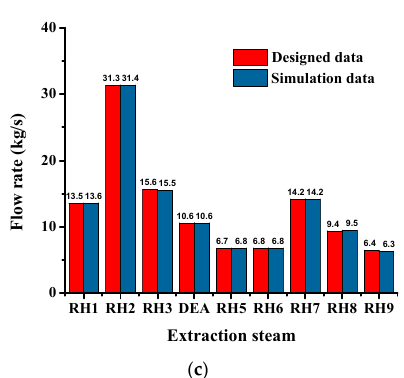
Figure 5. Comparison of the simulation data and designed data of extraction steam flow rate. ( a ) High load; ( b ) Medium load; ( c ) Low load.